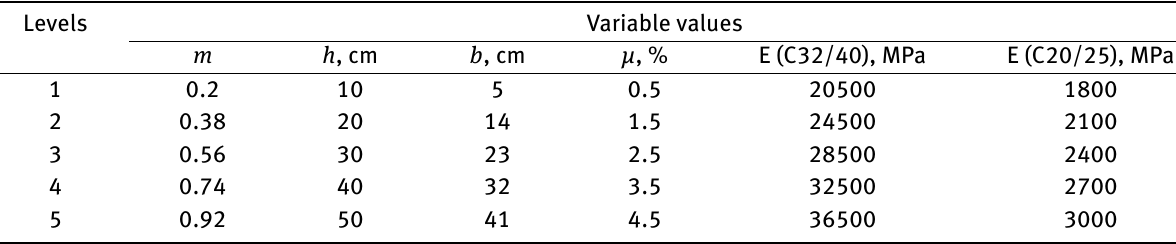
Table 1: The values of the variable parameters at different levels